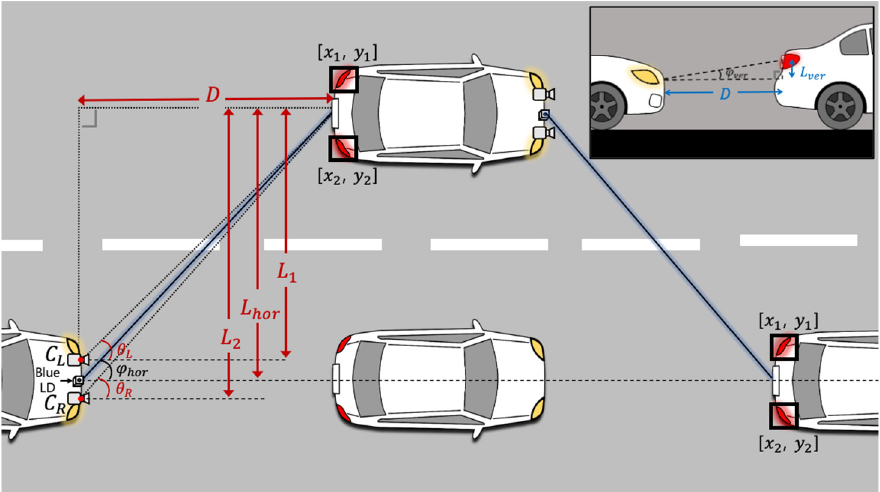
Figure 4. Geometric configuration for top and side views.